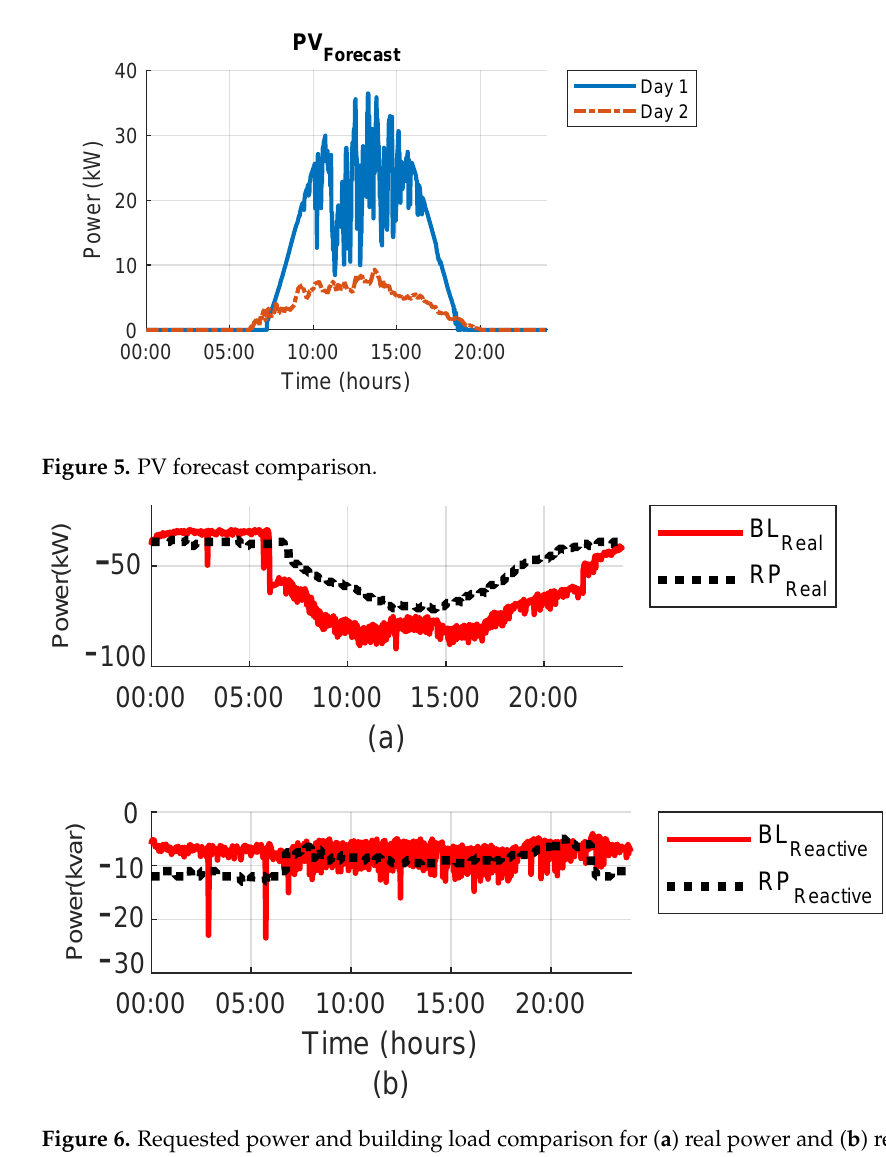
Figure 6. Requested power and building load comparison for ( a ) real power and ( b ) reactive